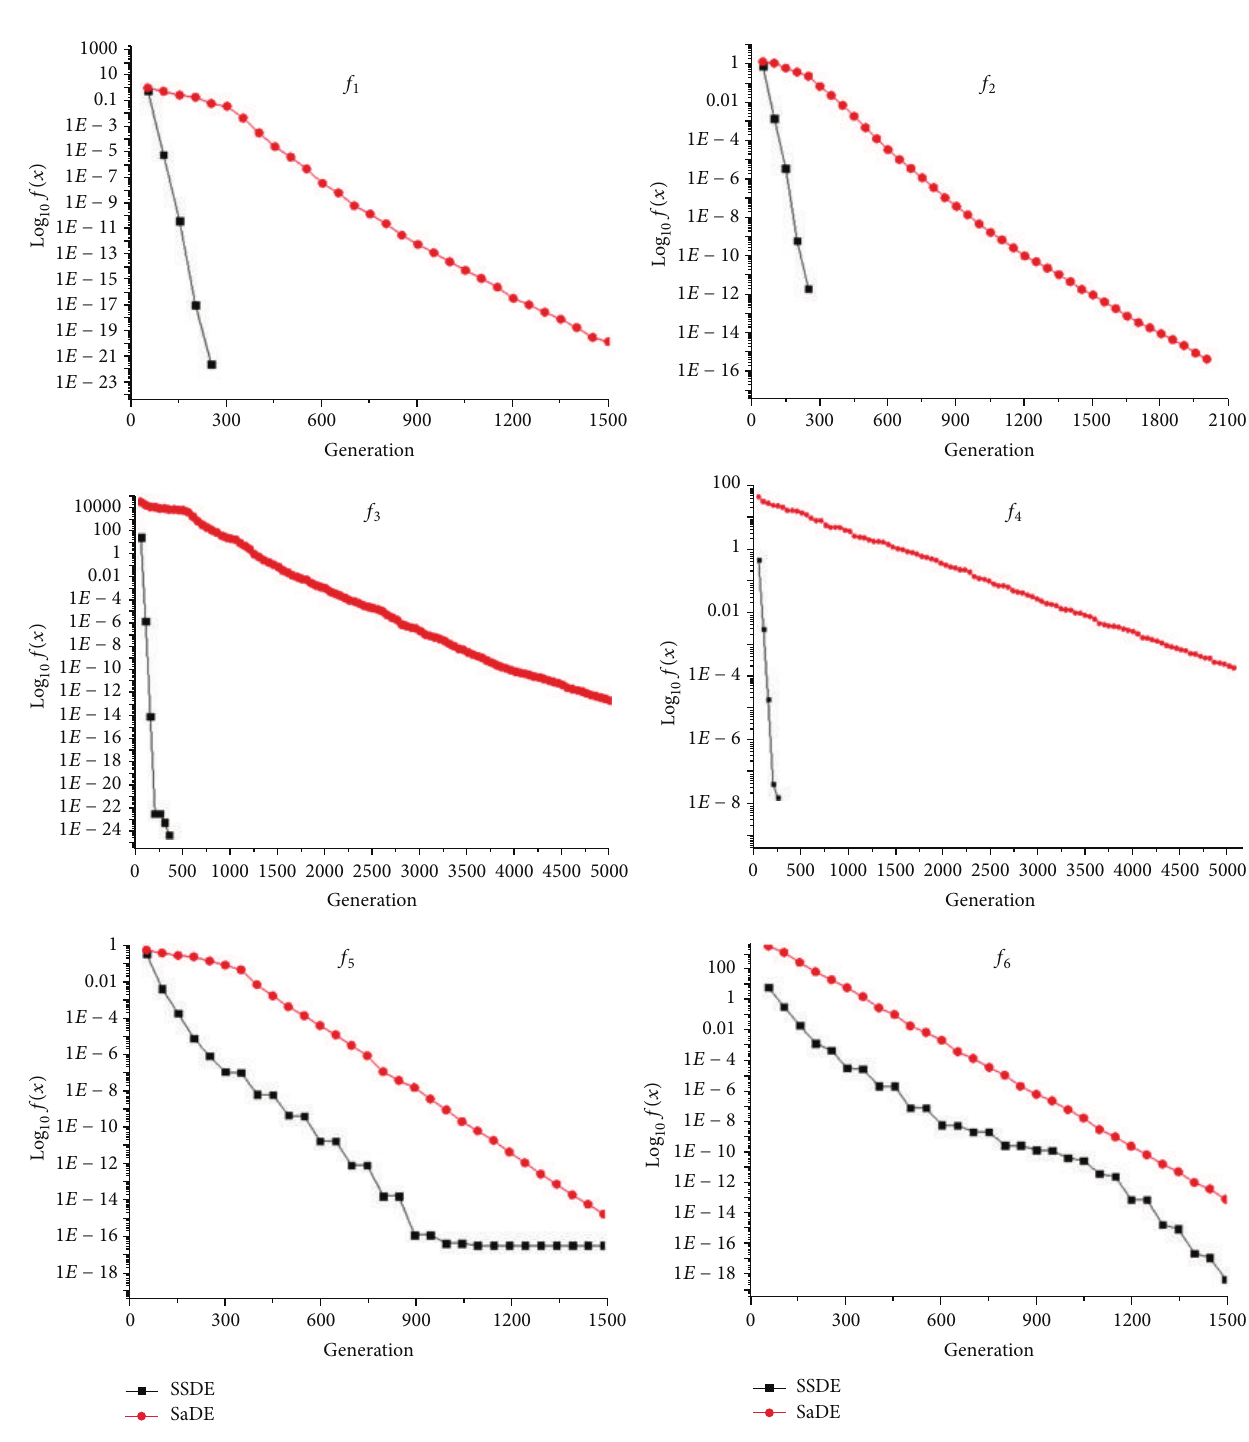
Figure 1: Evolution process of SSDE and SaDE for functions 𝑓 1 – 𝑓 6